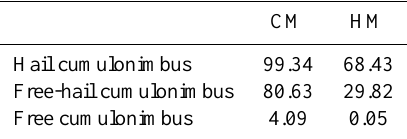
Table 7. Contingency table for HM database.